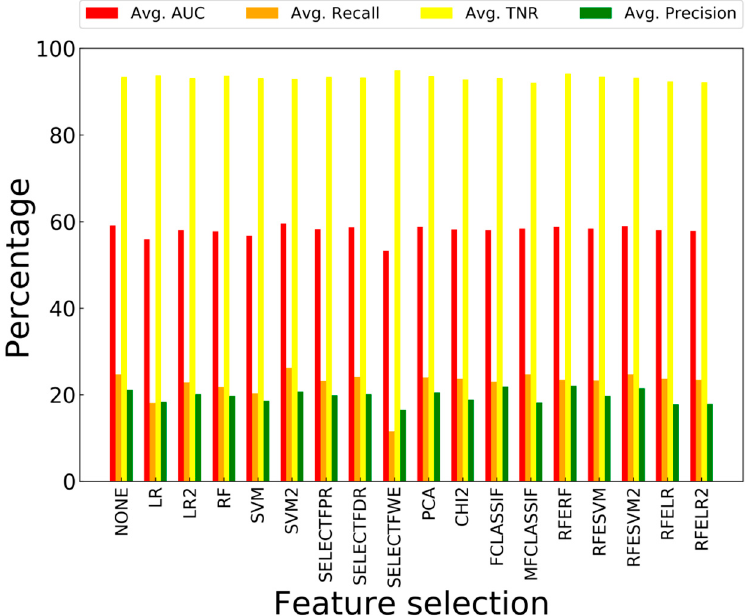
Figure 8. Average performance of each feature selection approach on imbalanced data.